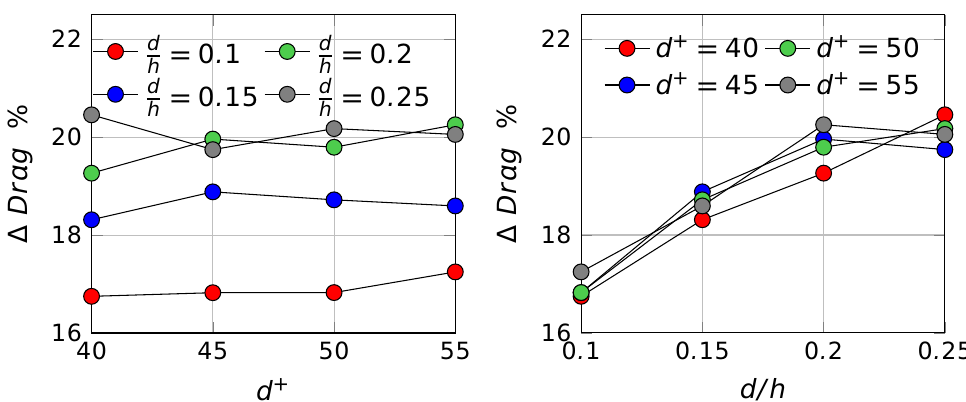
Figure 7. Present simulations, circular dimples at various sizes and Reynolds numbers with 2690 ≤ Re b ≤ 10,450. Left : drag changes vs. dimple depth in inner units. Right : drag changes vs. dimple depth in outer